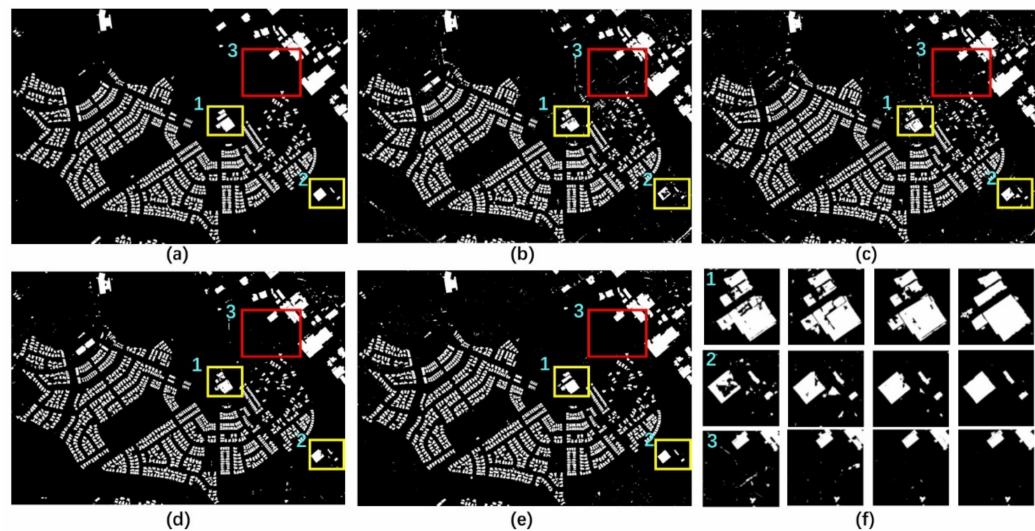
Figure 10. Test results of ablation experiment. ( a ) Ground truth. ( b ) TDA-Net_noprenoatt.